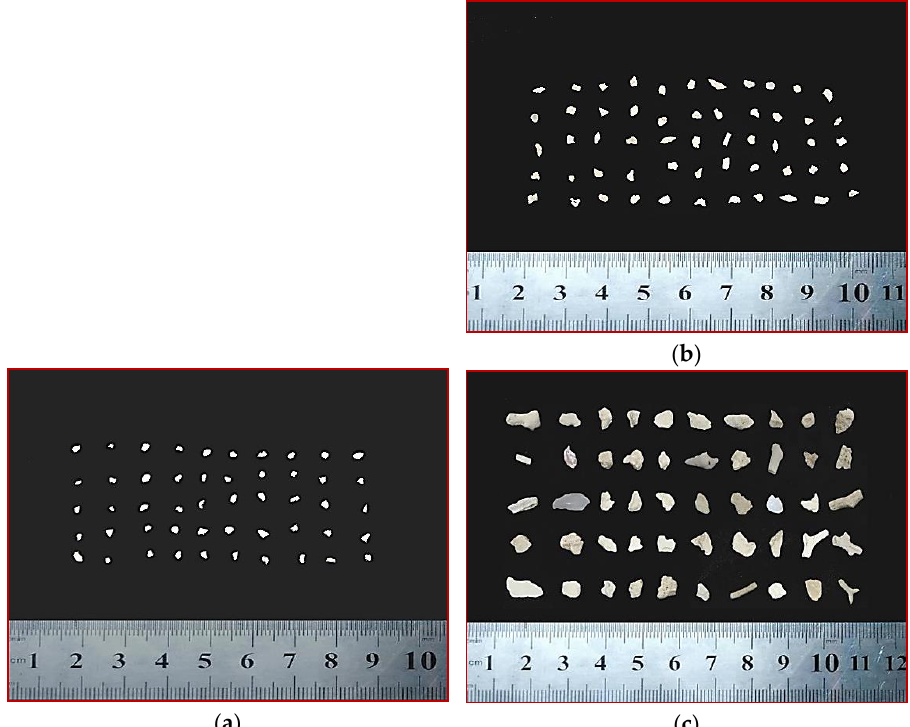
Figure 11. Coral sand with different particle sizes: ( a ) D = 0.5–1.0 mm, ( b ) D = 1.0–2.0 mm, and ( c ) D = 2.0–5.0 mm.